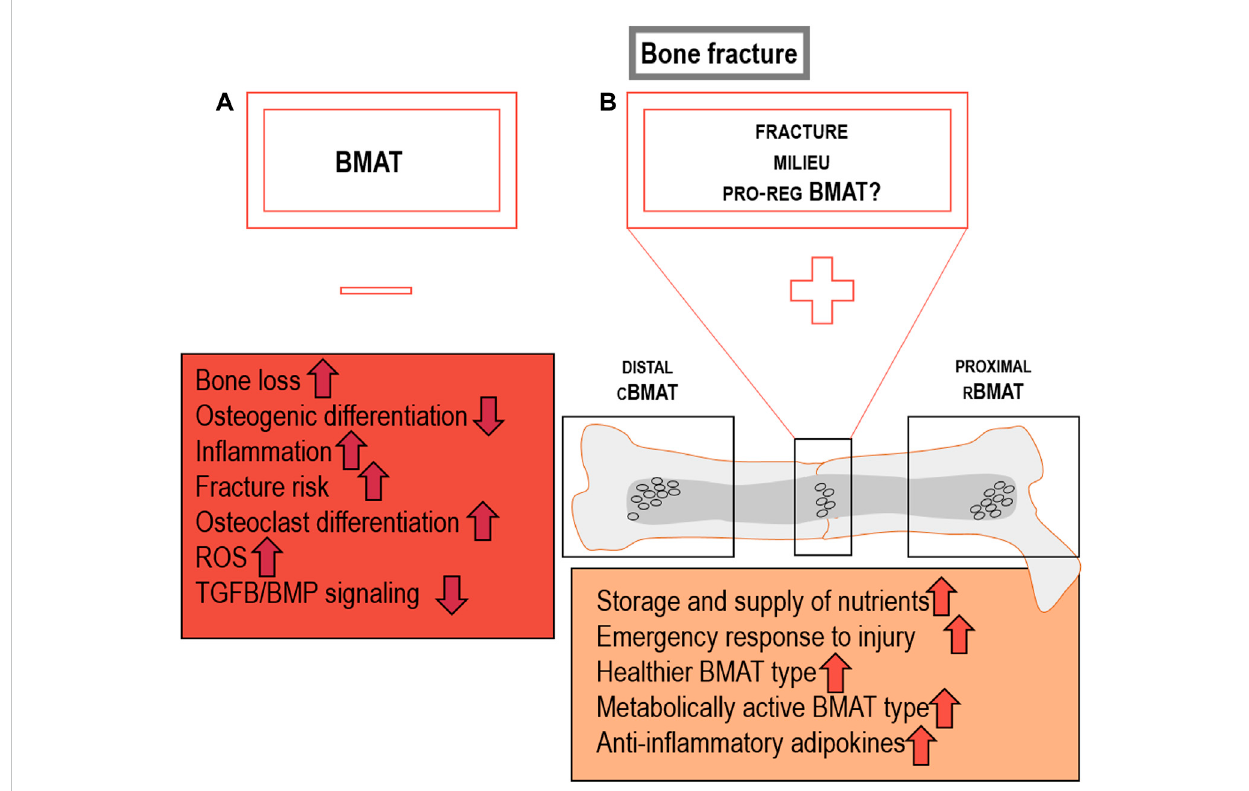
FIGURE 5 DetrimentalBMAT characteristics are dependent on thelocation and milieu the BMAds: (A) BMAT may exert detrimental effects on bone by causing lossofbonemassandenhancingfractureriskbyreducingosteogenicdifferentiation,TGFb/BMPsignalling,whileinducingosteoclastdifferentiation,ROS andin fl ammation(Lazarenkoetal.,2007;Kahnetal.,2008;Ackert-Bicknelletal.,2009;Tangetal.,2009;Schelleretal.,2015;Falanketal.,2016;Linetal., 2017;Ammazzalorsoetal.,2019). (B) PPARG-driven, potentiallypro-regenerative featuresoflocalBMATatthefracturesitewhichcouldincludethe storage and supply of nutrientsto surrounding cells, representation as an energy hub for emergency responses, characterized as healthier, metabolically active, and anti-in fl ammatory BMAT type. BMAT could be recruited de novo or through plasticity of pre-exiting local adipocytes that convert into a regeneration-supportive